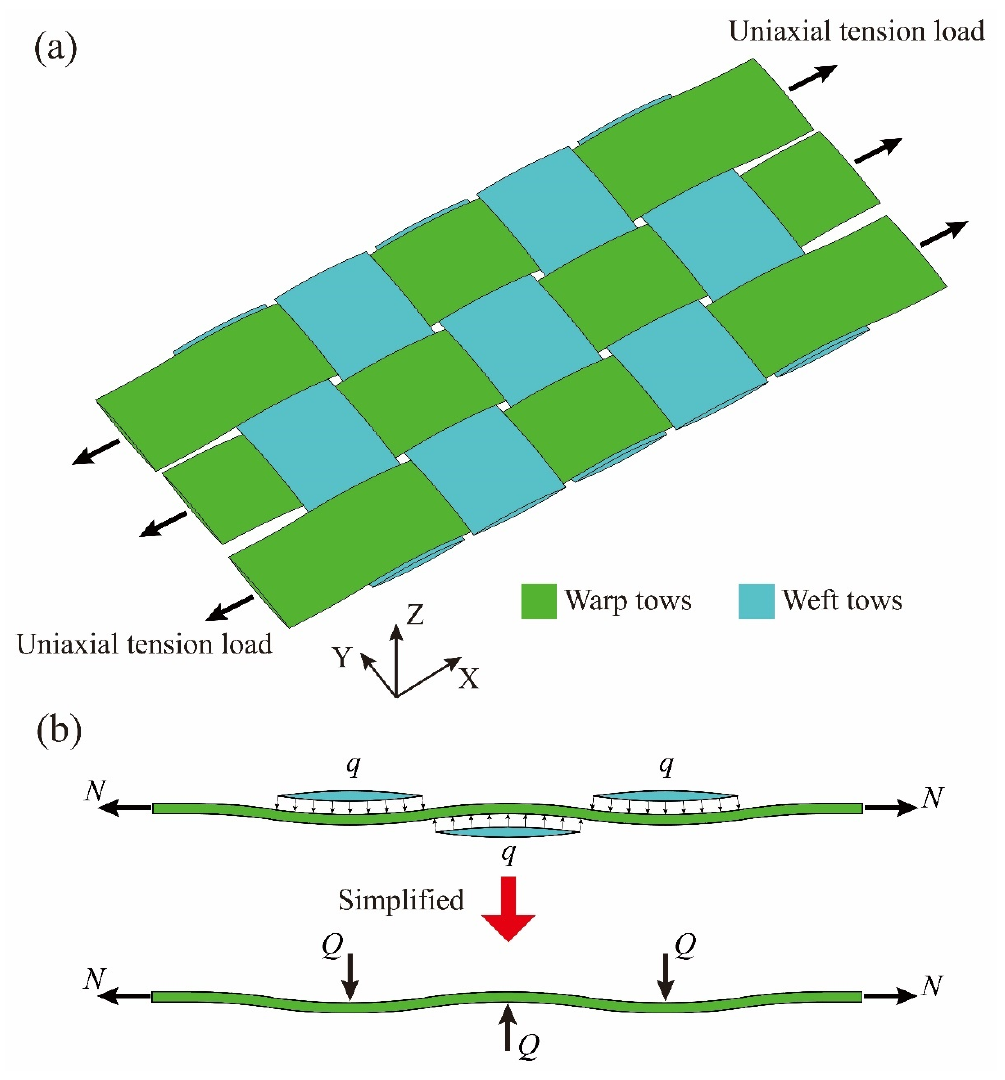
Figure 4. Interactions between the fiber tows: ( a ) the monolayer of the plain-woven fabric composites under uniaxial ten- sion load; ( b ) simplification of the interactions between the warp and weft